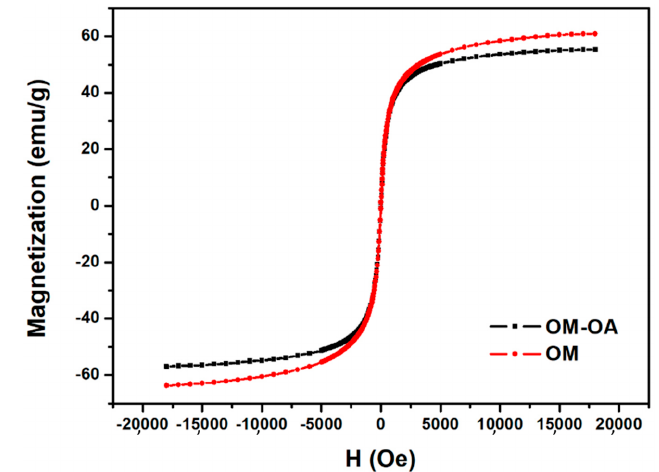
Figure 2. Magnetization curves as a function of the magnetic field applied at room temperature of samples OM and OM-OA.